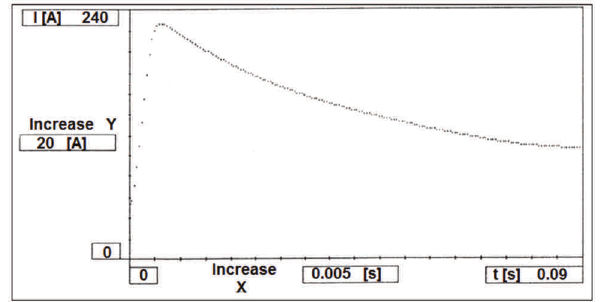
Fig. 4. Graph of the current drawn by the starter as a function of time